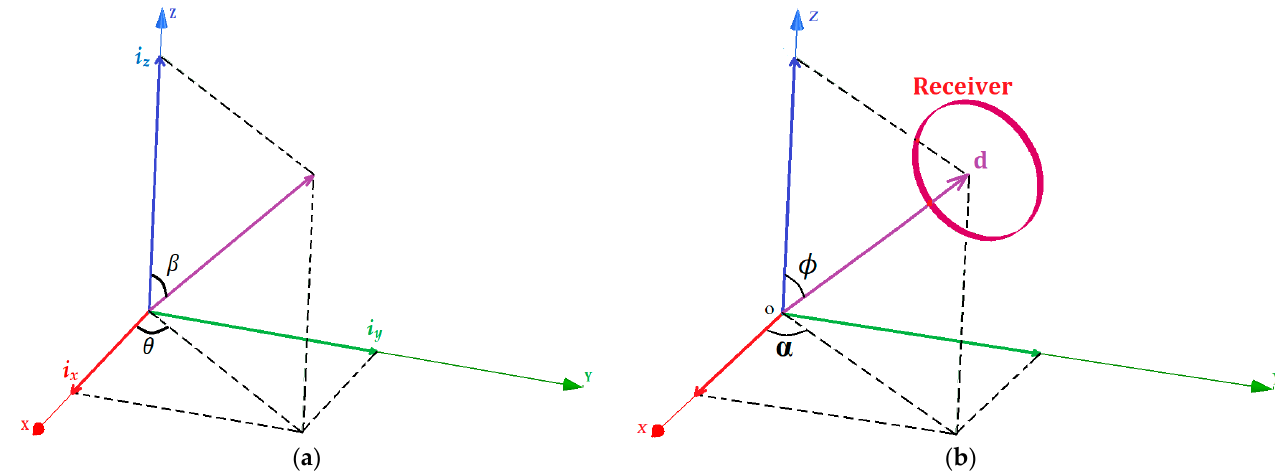
Figure 2. ( a ) The representation of the AC currents flowing in the 3D transmitting coils in the spherical coordinates. ( b ) The representation of the receiver position in the spherical coordinates. The three transmitting coils (T x , T y , and T z ) of the WPT system produce the resultant magnetic and electric vectors B and I represented by the angular direction θ and β in the spherical coordinates. The relationship between the electric resultant vector I and the currents i x , i y , and i z flowing in the transmitting coils (T x , T y , and T z ), respectively, is described by Equation (3).